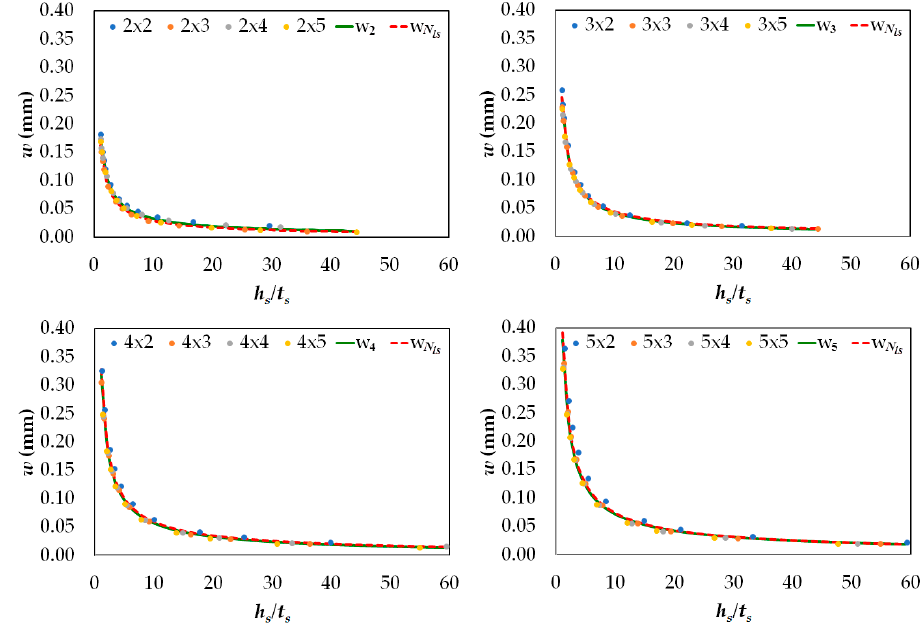
Figure 8. Numerical results versus analytical results for the central deflection of stiffened plates.